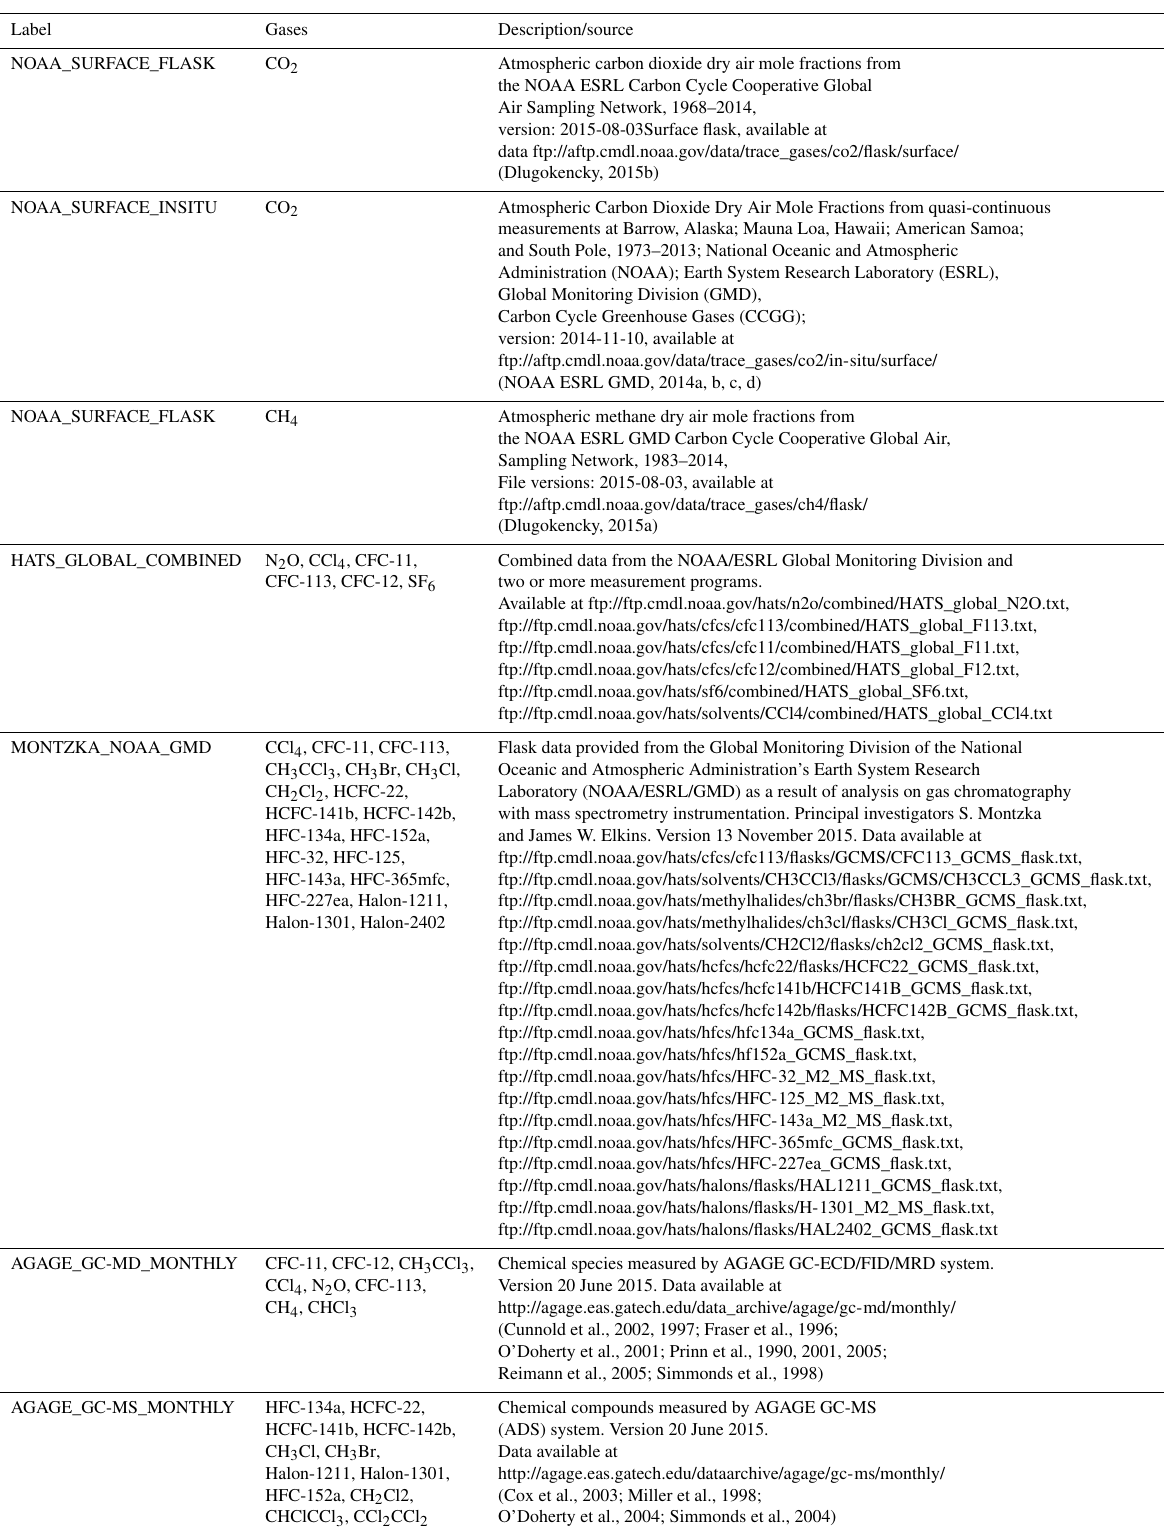
Table 12. Description of data labels shown in fact sheets, namely Figs. 9, 11, 12, and S1 to S40.